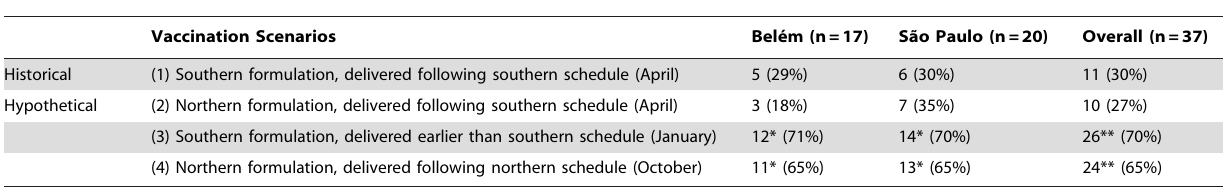
Table 2. Success of vaccination campaigns in Brazil for the historical and simulated alternative strategies (1999–2007).